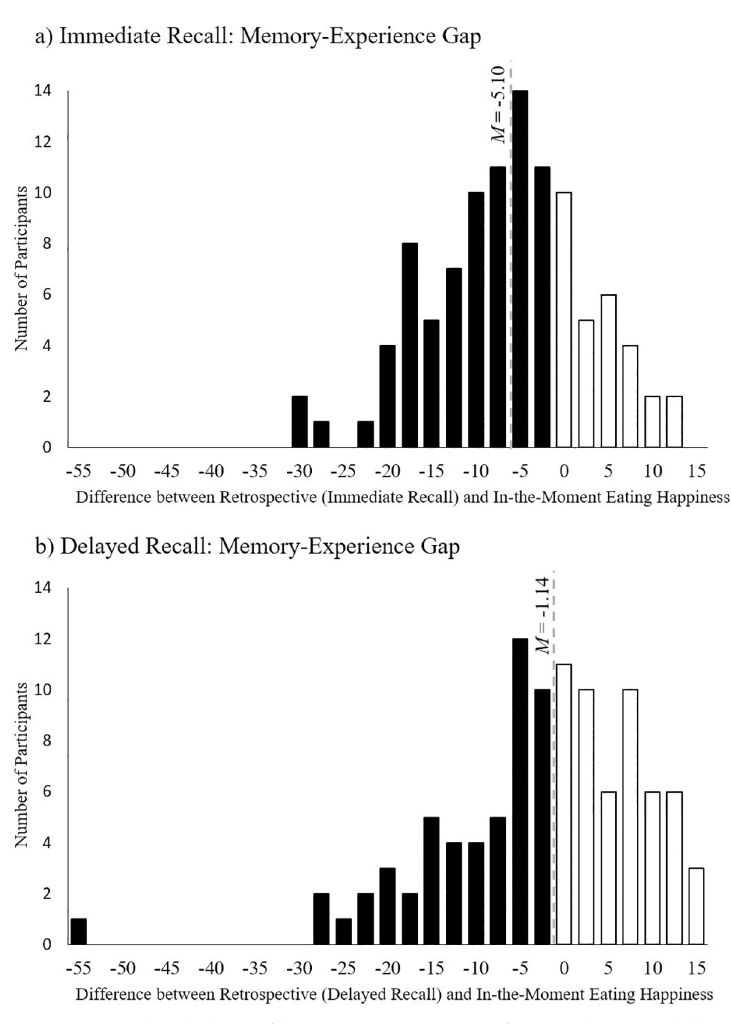
Fig 3. Magnitude and valence of the memory-experience gap for immediate (a) and delayed (b) recall. Bins represent the number of participants.